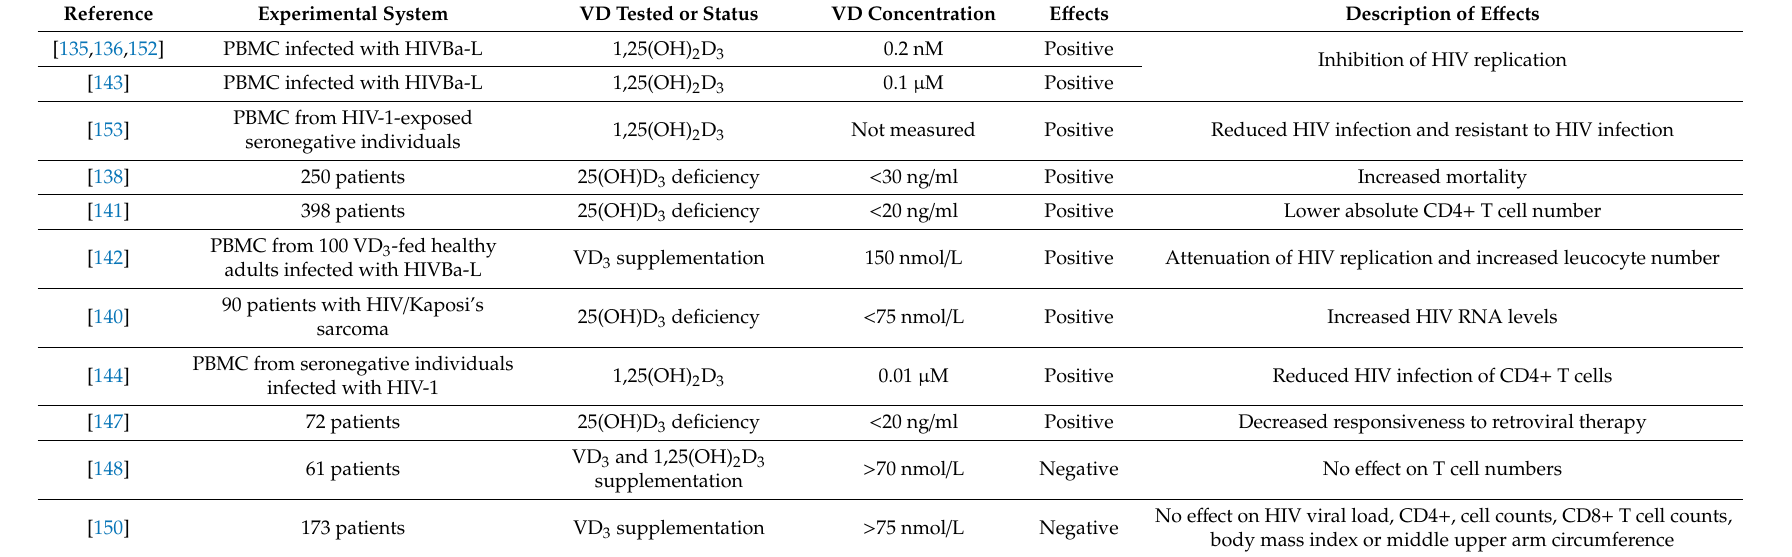
Table 4. E ff ects of VD human immunodeficiency virus (HIV) infection, pathogenesis, and treatment